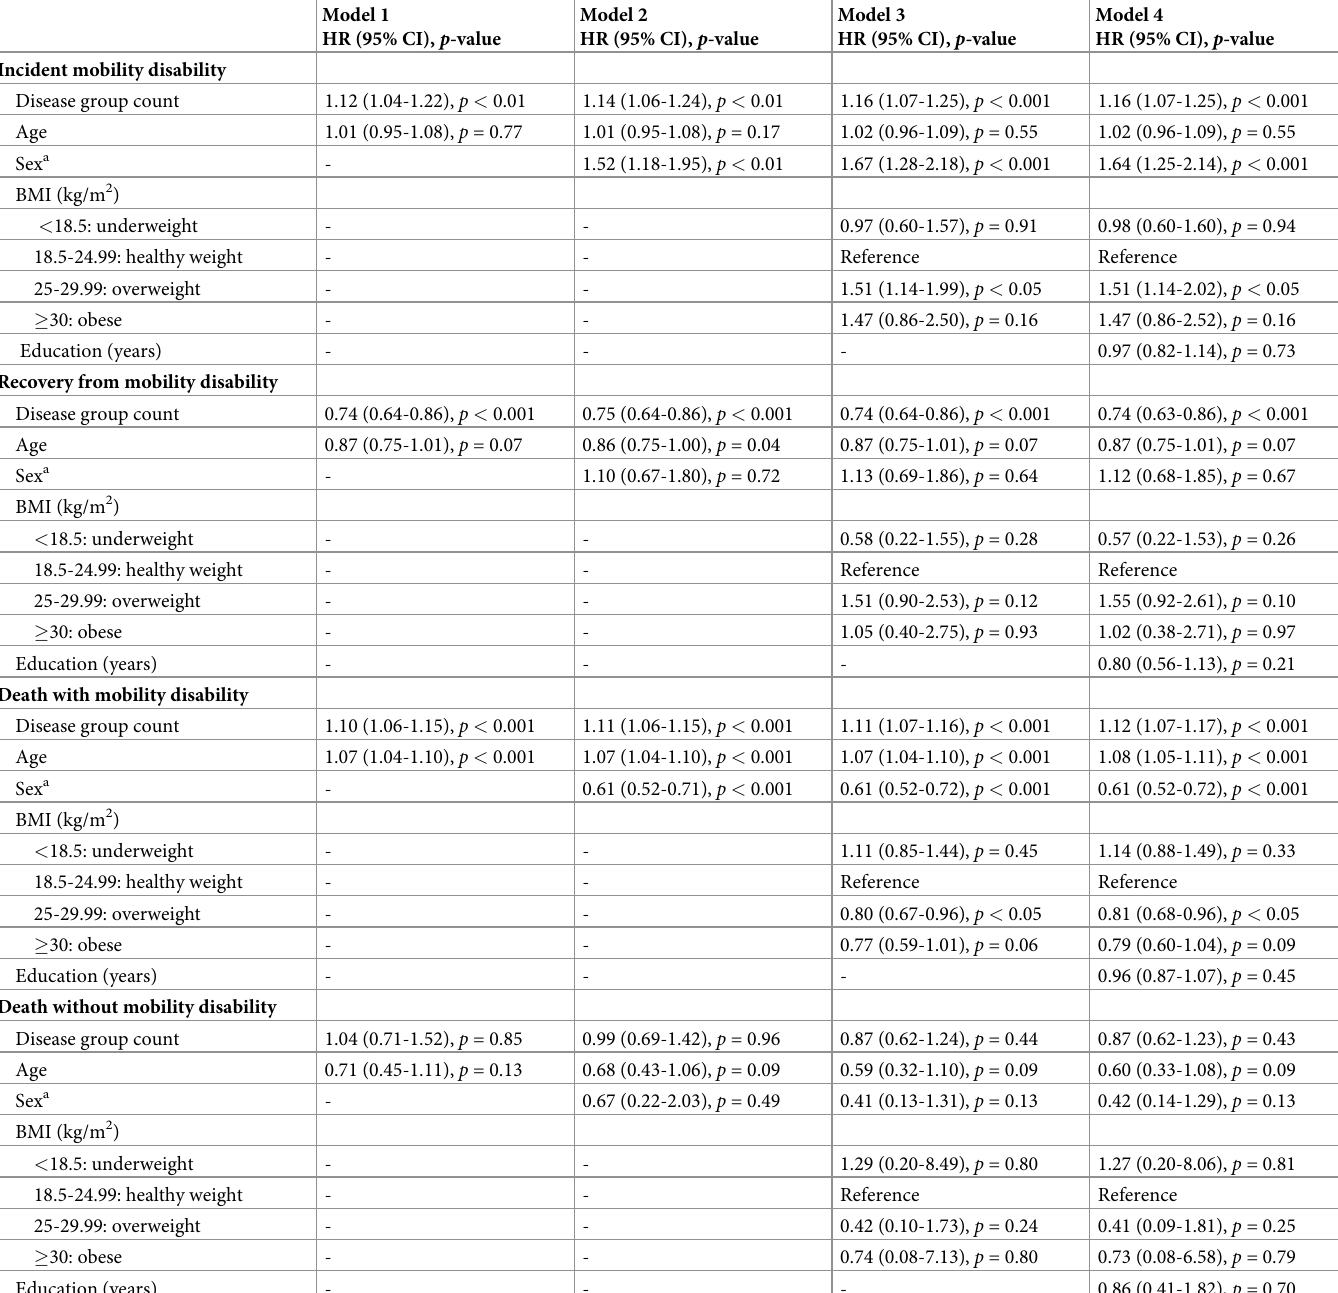
Table 2. Hazard ratios (HR) and 95% confidence intervals (95% CI) for transitions between mobility disability states and